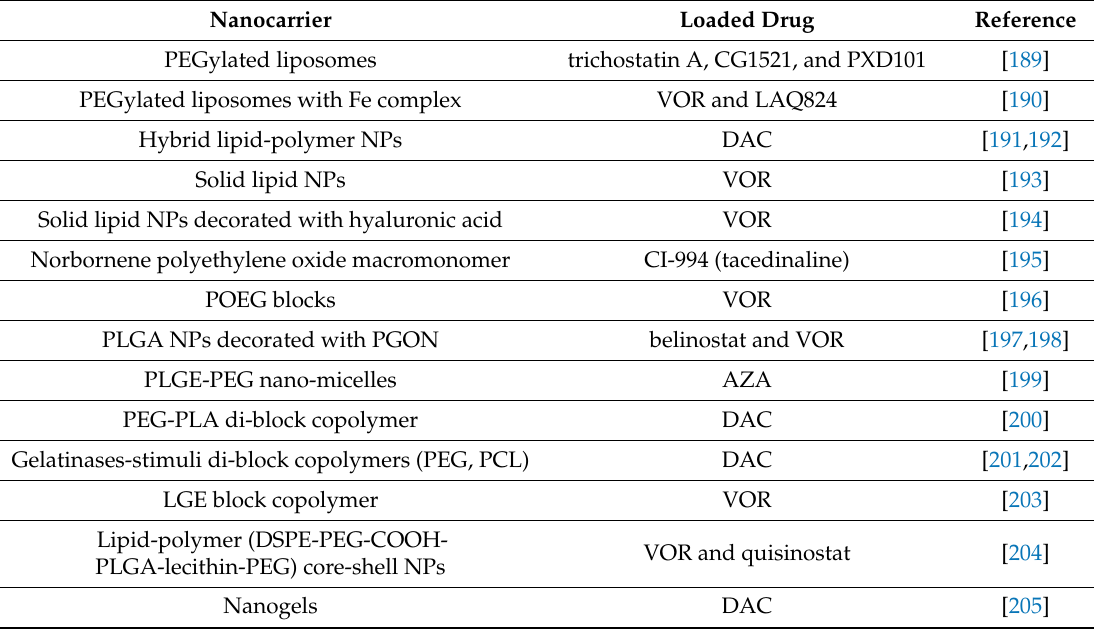
Table 2. Nanoplatforms for epigenetic drug